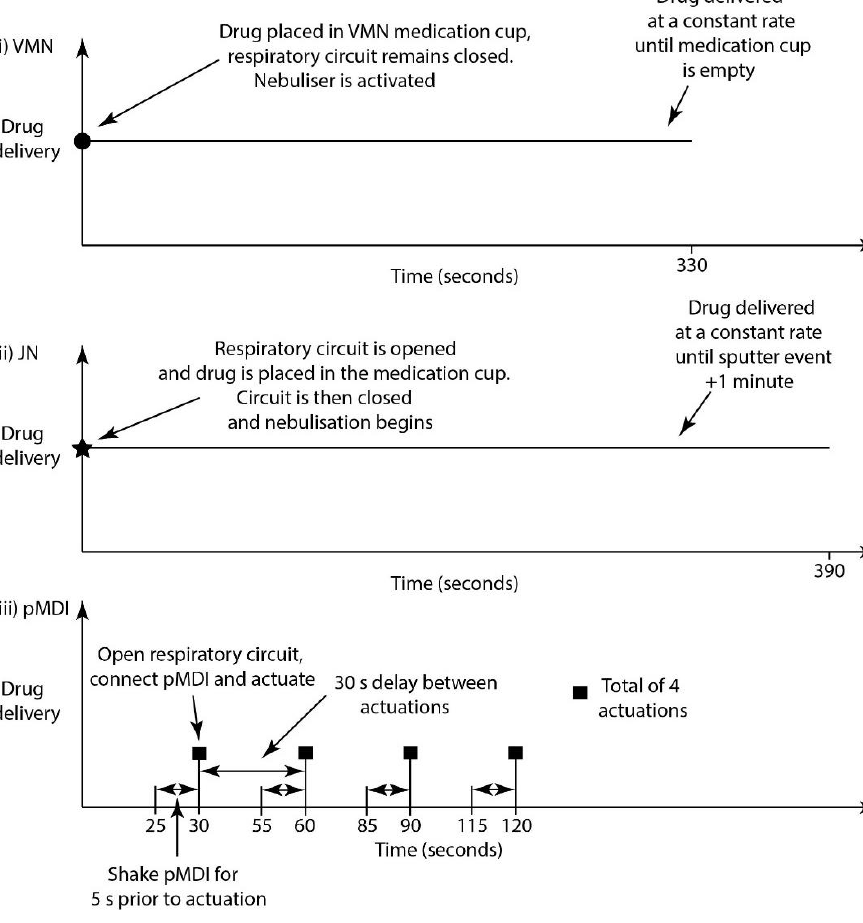
Figure 1. Stages in aerosol drug delivery to a mechanically ventilated patient via ( i ) VMN, ( ii ) com- pressed air-driven JN and ( iii ) pMDI.